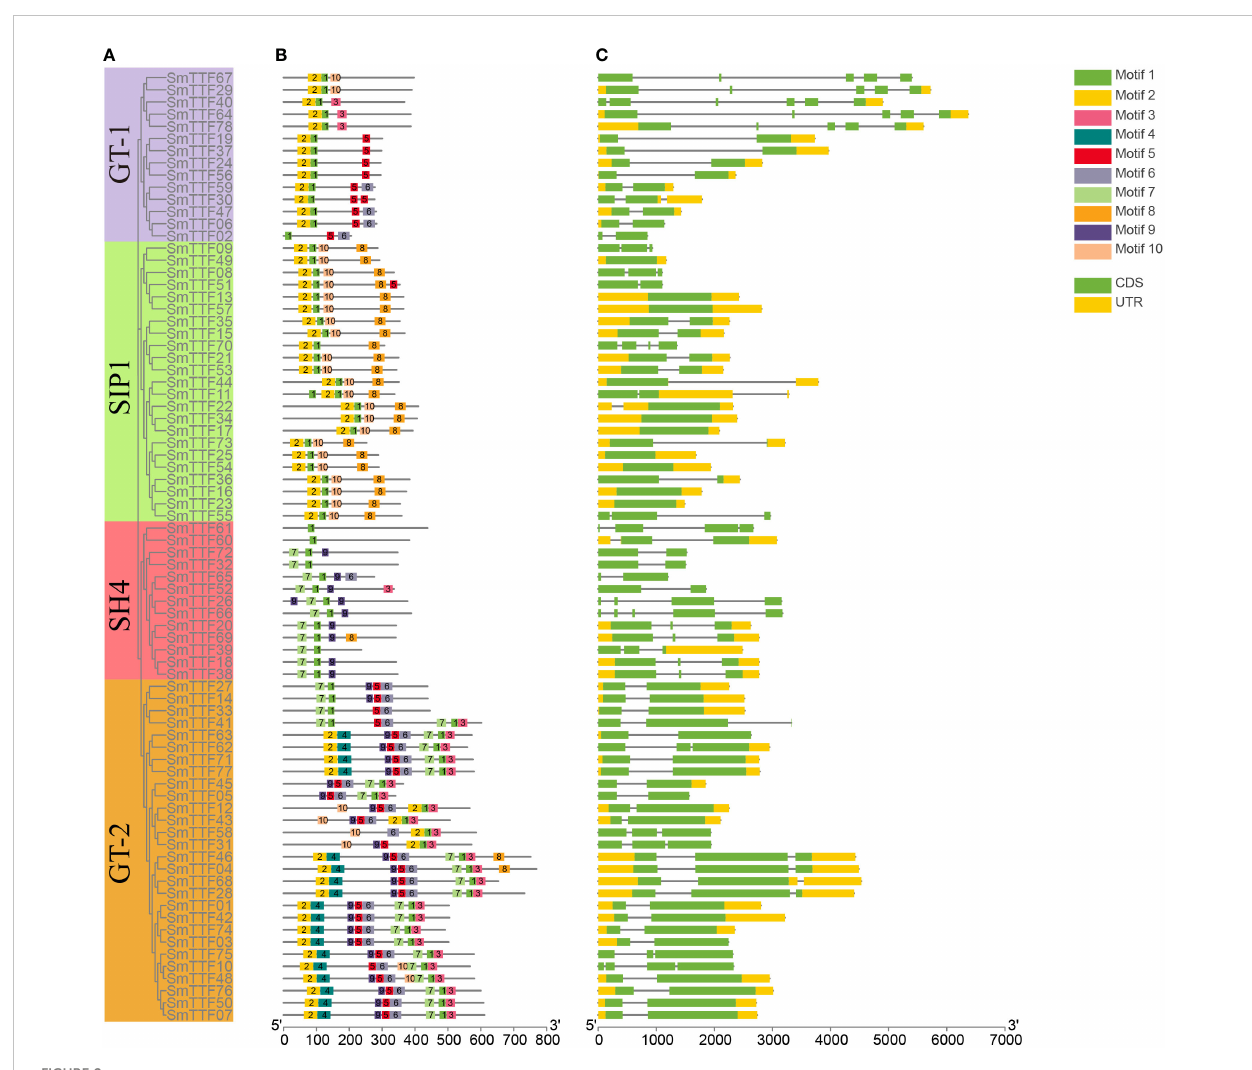
FIGURE 2 Structures and conserved motifs of SmTTF genes. (A) The phylogenetic tree was constructed based on the amino acid sequences of S. matsudana trihelix proteins. Different colored branches represent different subfamilies. (B) The motif compositions of S. matsudana Trihelix proteins. Motifs 1-10 are marked in different colored boxes. (C) Gene structure of the S. matsudana trihelix family. CDS, introns, and untranslated regions are marked by green boxes, gray lines, and yellow boxes,